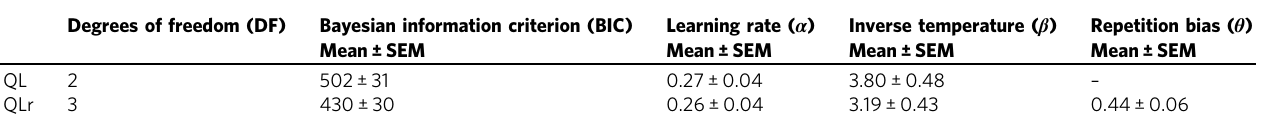
Table 1 Model parameters and comparison